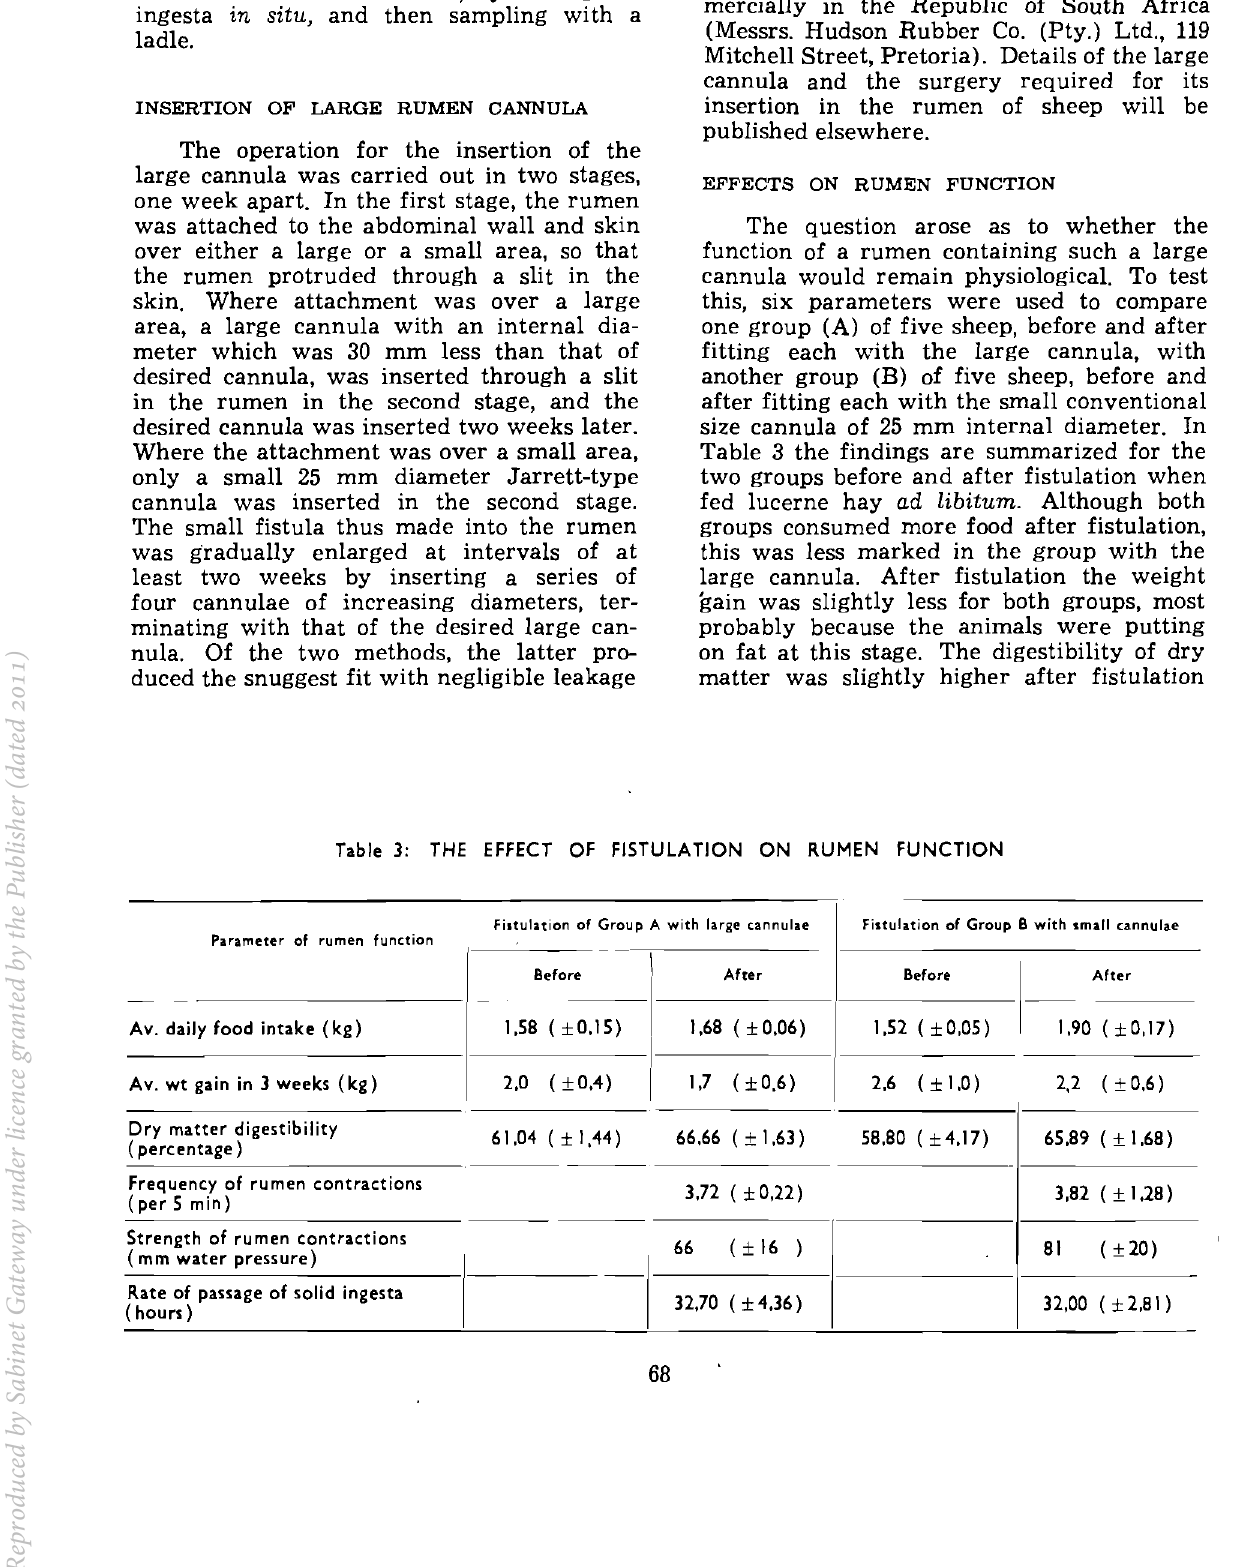
Fistulation of Group A with large cannul.e Fiuul.tion of Group B with small cannulae Parameter of rumen function Before After